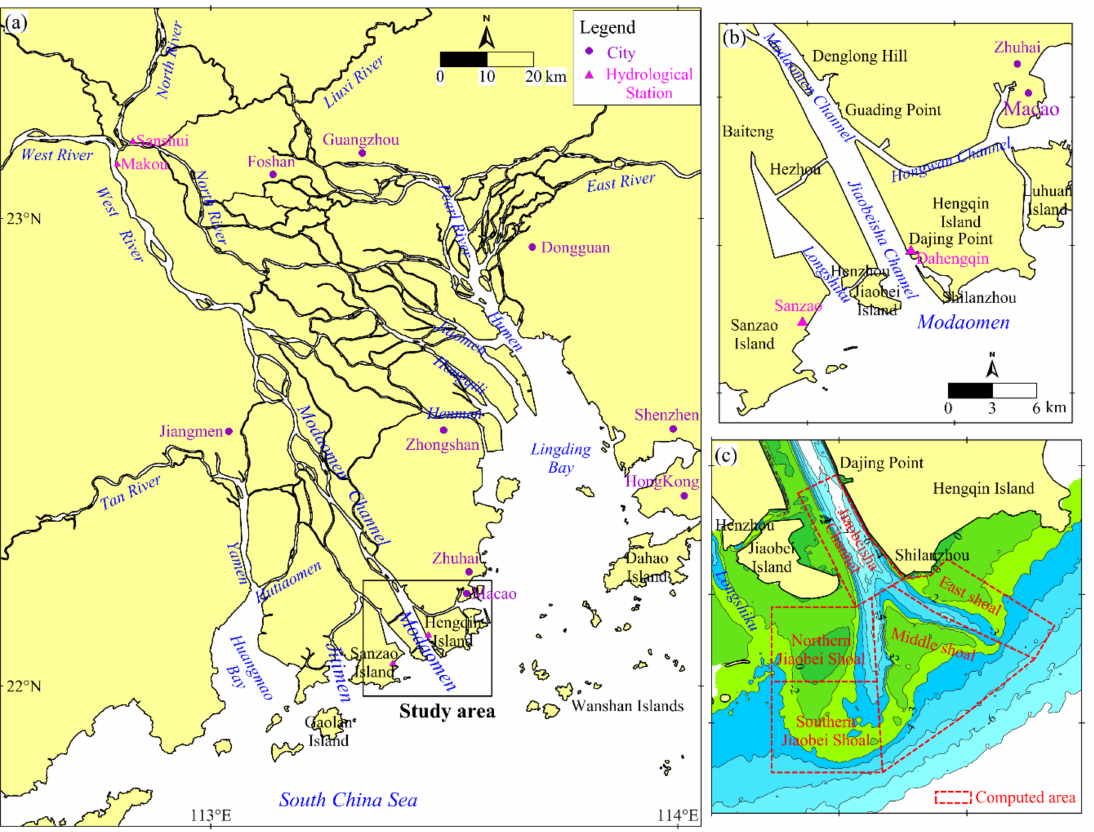
Figure 1. Sketch map of the PRE ( a ); the Modaomen Estuary ( b ) and computed area of the mouth bar ( c